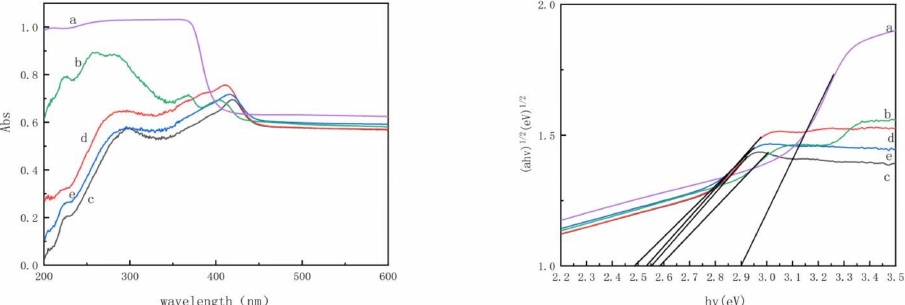
Figure 7. UV-vis diffuse reflectance spectra ( left ), (Ahv) 1/2 and hv relationship curves ( right ): Raw cotton ( a ), ZnO/cotton ( b ), OA-ZnO/cotton ( c ), TA-ZnO/cotton ( d ), and SA-ZnO/cotton ( e